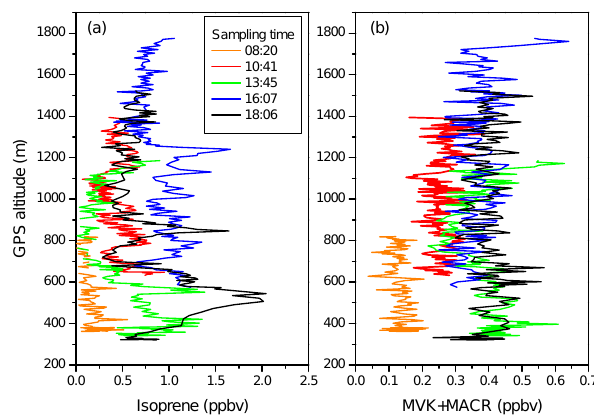
Fig. 12. The vertical profiles of (a) ambient air temperature and (b) relative humidity on 10 August 2012. The sampling time indi- cates the beginning of each flight in local time. Altitude is given in meters above mean sea level; elevation of Columbia is 200m